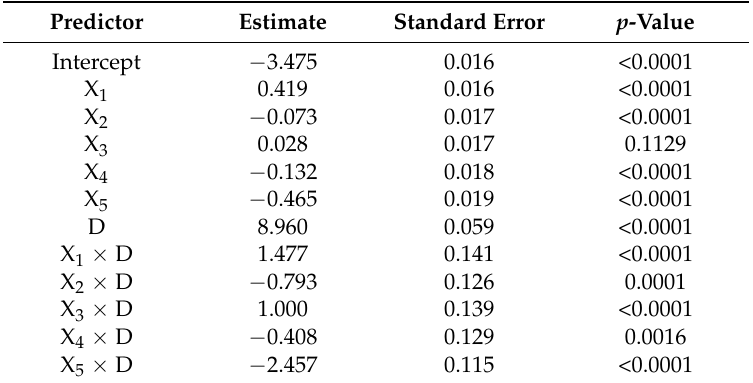
Table 1. Estimates, standard errors and p -values of the binary logistic regression model presented in